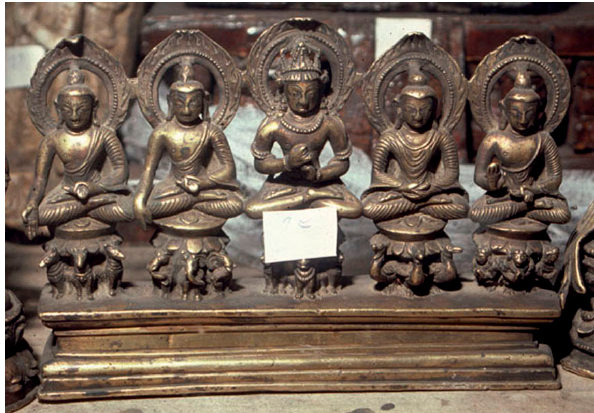
Figure 24. Pa ῆ ca jina Buddhas with crowned Vairocana, seventh to eighth c. Kashmir. Brass. H 14.7 cm W. 25.6 cm. Po ta la Collection: Li ma lha khang: inventory no. 567. Red Palace, Lhasa, Tibet. https://himalayanbuddhistart.wordpress.com/category/all/tibet/buddhas-masculine-form/amitabha/.